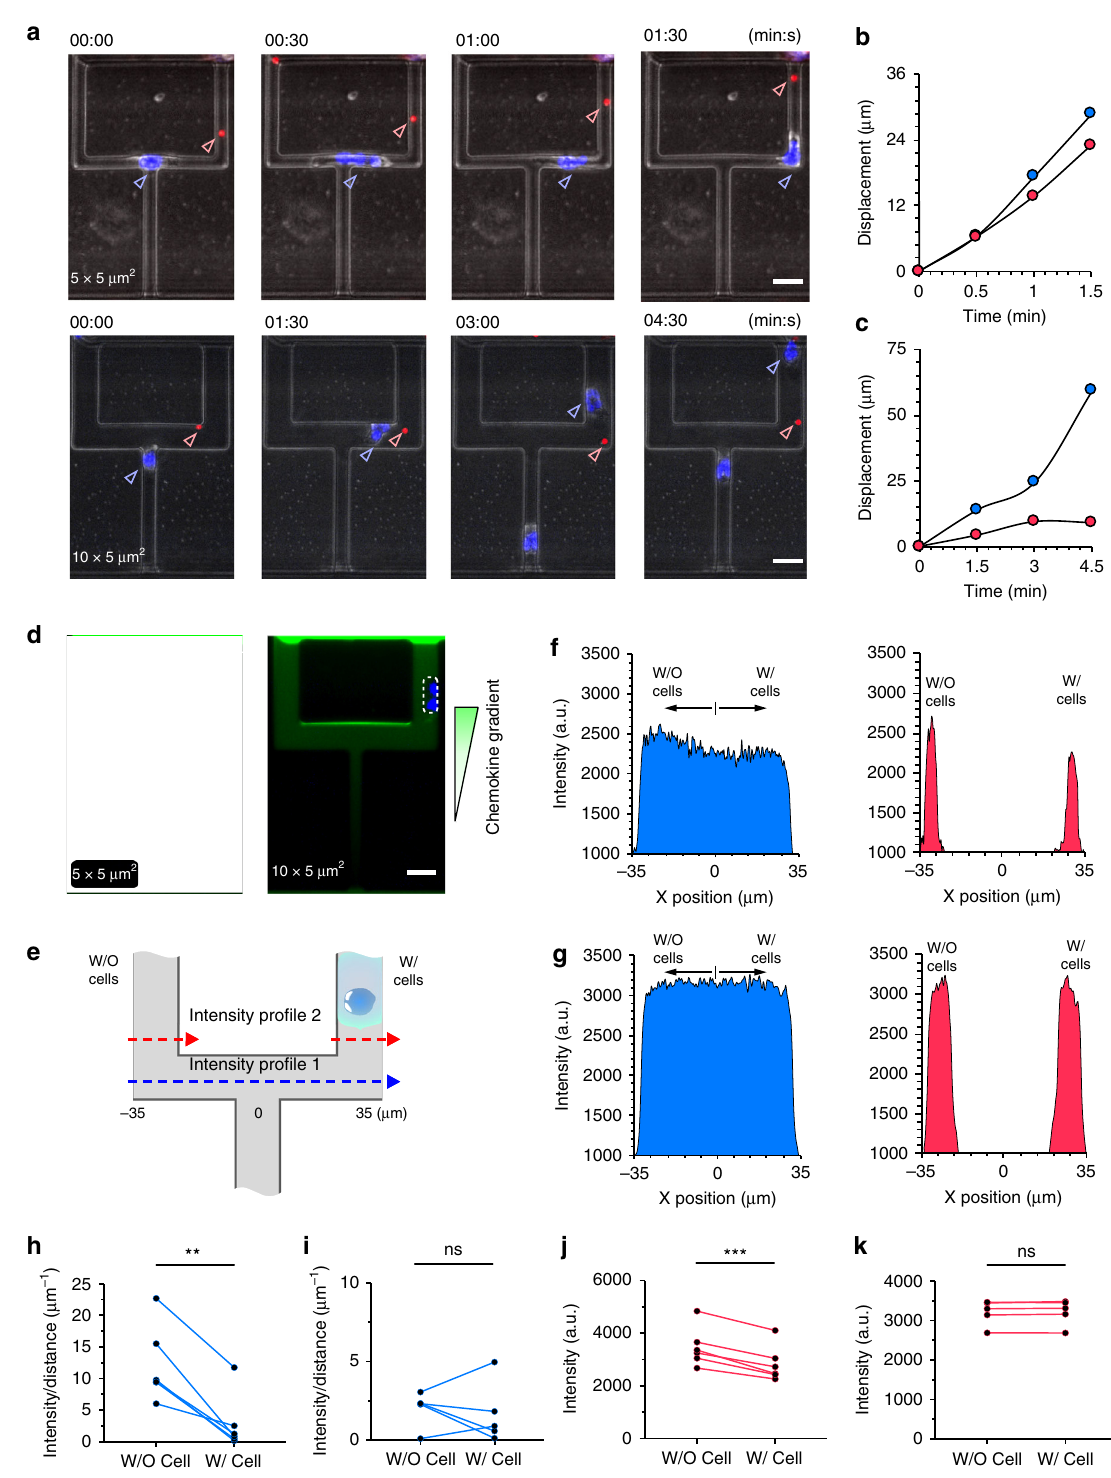
Fig. 6 Neutrophil alters the hydraulic resistance and the chemoattractant gradient in the bifurcation. a Time-lapse microscopic images showing the migration of the neutrophils and the corresponding movement of the 2 µ m diameter beads. The scale bar is 10 µ m. The displacements of the neutrophil (blue) and the microbead (red) over time in 5 × 5 µ m 2 ( b ) and 10 × 5 µ m 2 ( c ) channels. d Representative fl uorescent microscopic images show the chemical gradient in the bifurcation in the presence of a neutrophil. The white dashed rectangles indicate neutrophils. The scale bars are 10 µ m. e A schematic showing the two measurement locations of the fl uorescent intensity pro fi les. The fl uorescent intensity pro fi les along the indicated lines in ( e ) in 5 × 5 µ m 2 ( f ) and 10 × 5 µ m 2 ( g ) channels. The blue and red areas correspond to pro fi le 1 and 2. The fl uorescence gradients in the two bifurcation branches without vs. with a neutrophil along pro fi le 1 in 5 × 5 µ m 2 ( h ) and 10 × 5 µ m 2 ( i ) channels. The peak fl uorescence intensity along pro fi le 2 in the branches without vs. with a neutrophil in 5 × 5 µ m 2 ( j ) and 10 × 5 µ m 2 ( k ) channels. (** p < 0.01, *** p < 0.001, paired, two-tailed t